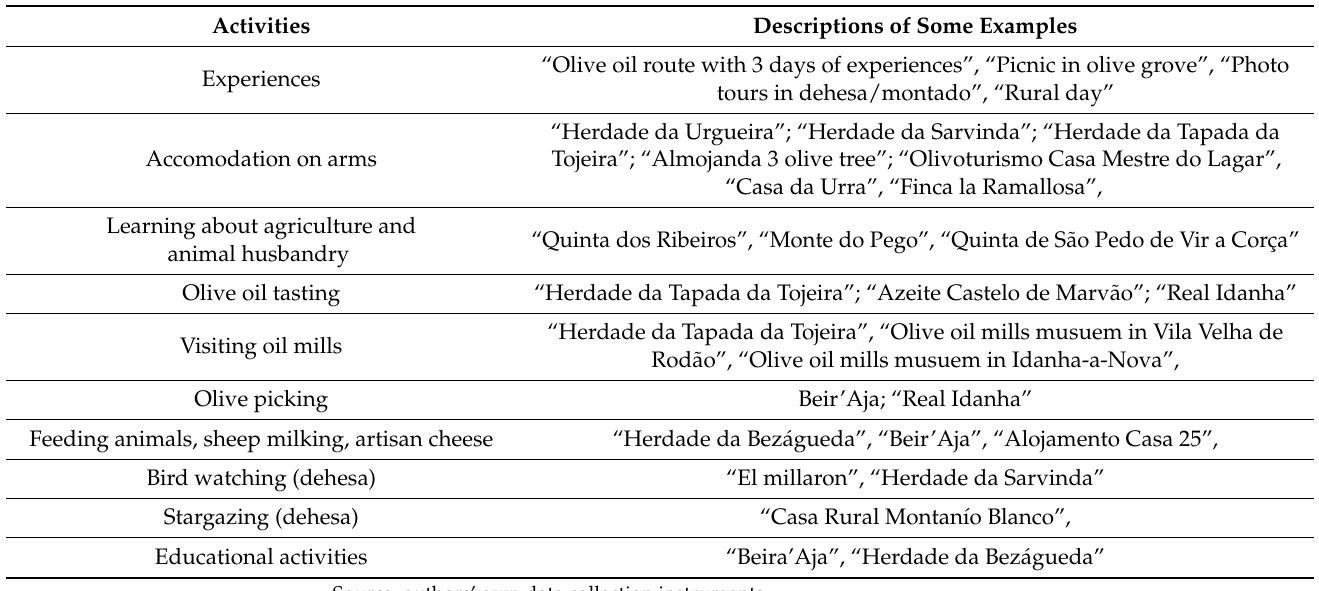
Table 4. Examples of agritourism activities found in the study